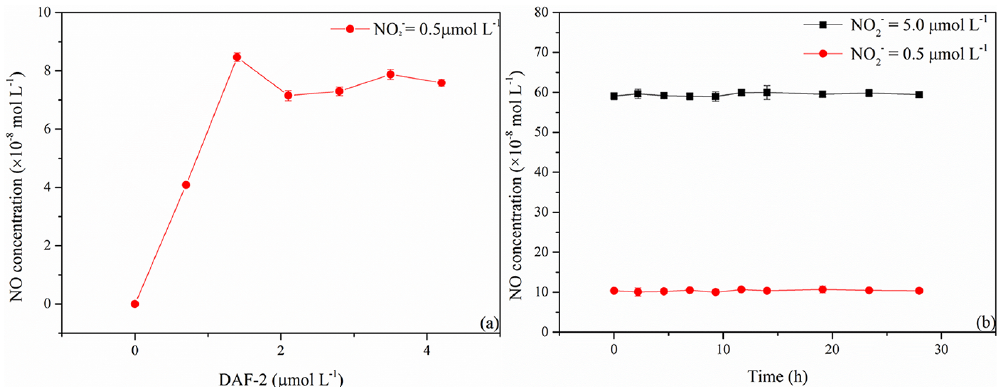
Figure 2. Changes in NO concentrations with initial DAF-2 concentrations of 0, 0.7, 1.4, 2.1, 2.8, 3.5, and 4.2µmolL − 1 after an irradiation time of 2h (a) and changes in different NO concentrations with storage time monitored at about 2h time intervals (b) .